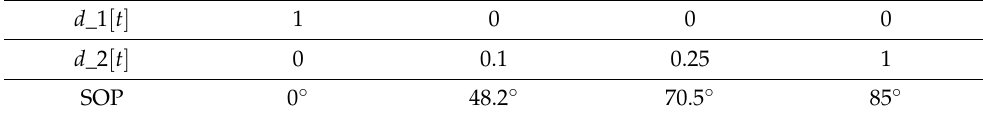
Table 3. SOPs of the four-level polarization shift on–off keying (4PS-OOK). d _1 [ t